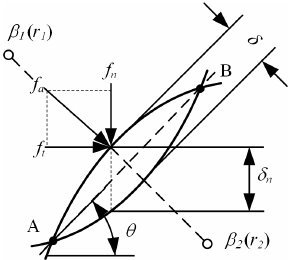
Figure 2. Overlap region showing normal and oblique interfer-